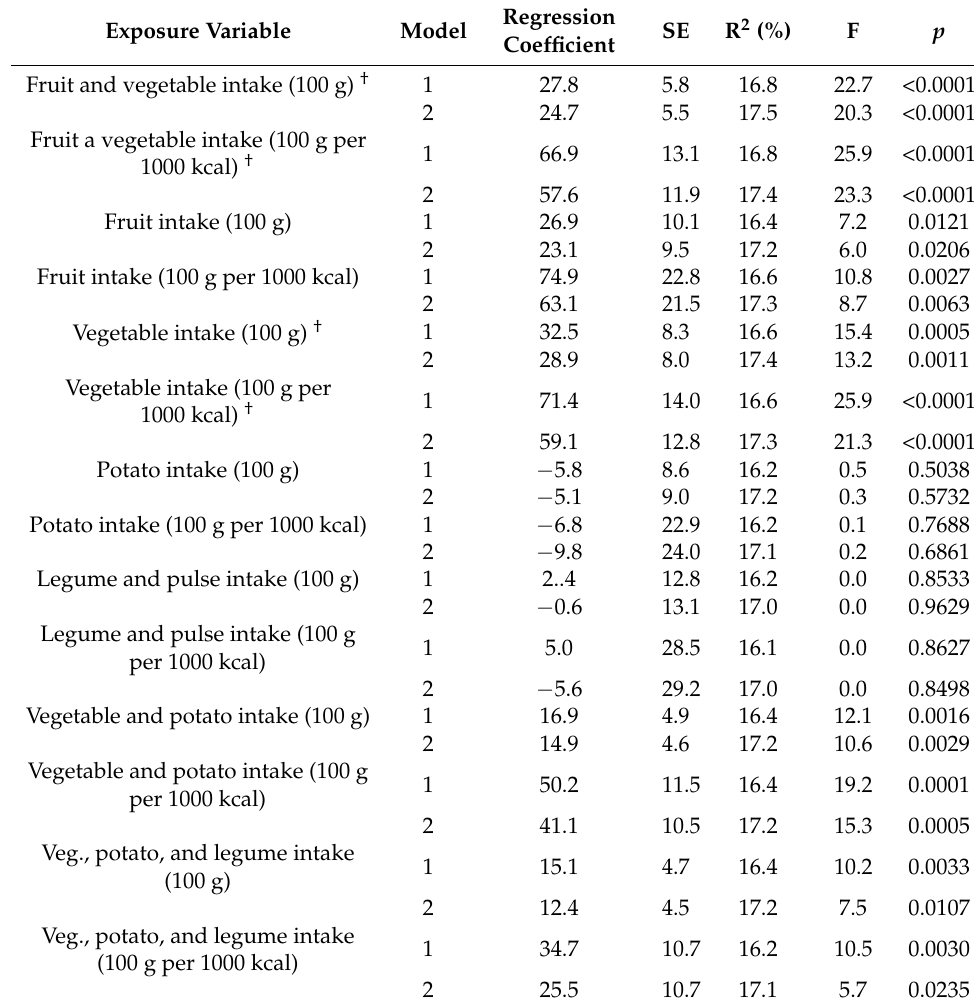
Table 2. Relationship between fruit and vegetable intake and telomere length in U.S. women and men